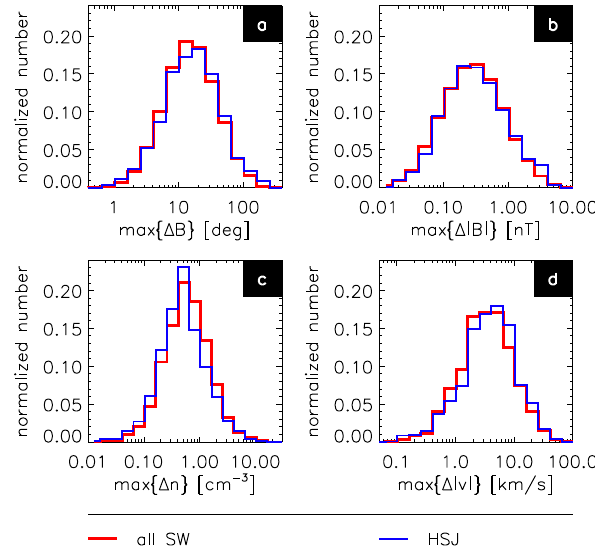
Fig. 7. Distributions of maximum variations in (a) the angle of the IMF, (b) the strength of the IMF, (c) the solar wind (SW) density, and (d) the solar wind velocity for all magnetosheath intervals (red) and for intervals preceding HSJ t 0 times